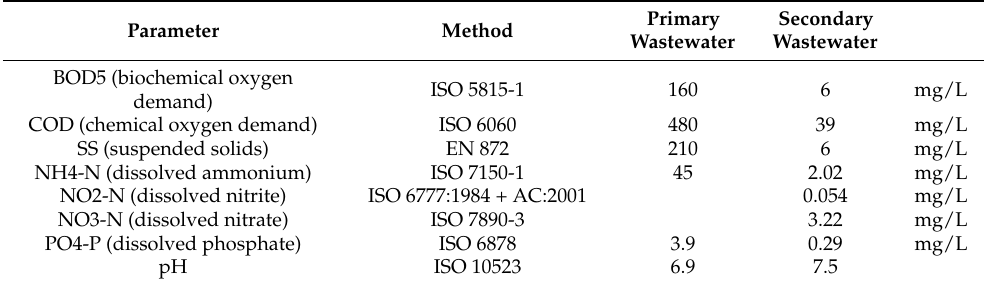
Table 1. Parameters of primary and secondary wastewater used for the experiments. Parameter Method